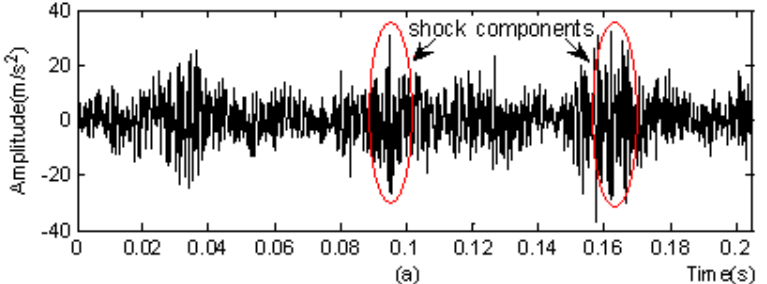
Figure 8. Basic analysis of vibration acceleration signals at measurement